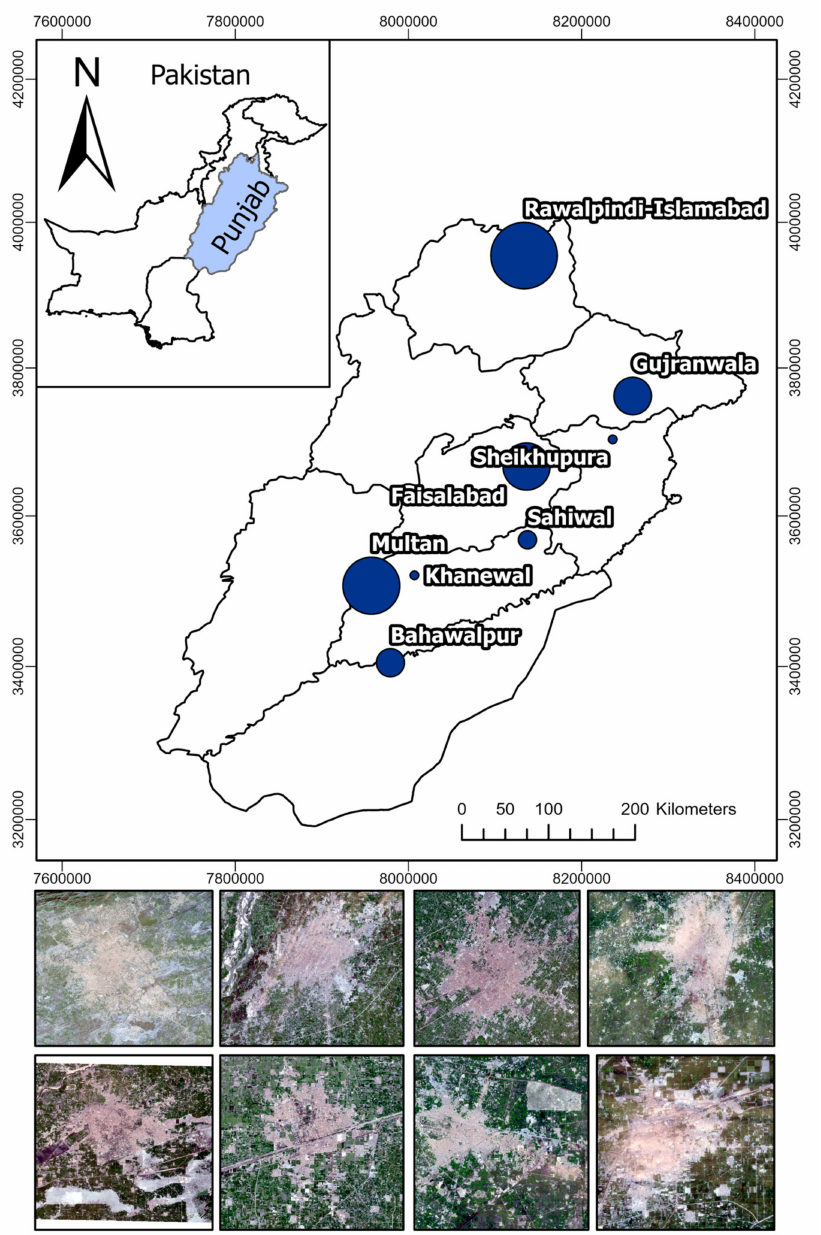
Figure 1. Location map of the study areas. True color composite images from Sentinel 2. (Left to right in upper row: Rawalpindi–Islamabad, Multan, Faisalabad, and Gujranwala, left to right in lower row: Bahawalpur, Sahiwal, Sheikhupura, and